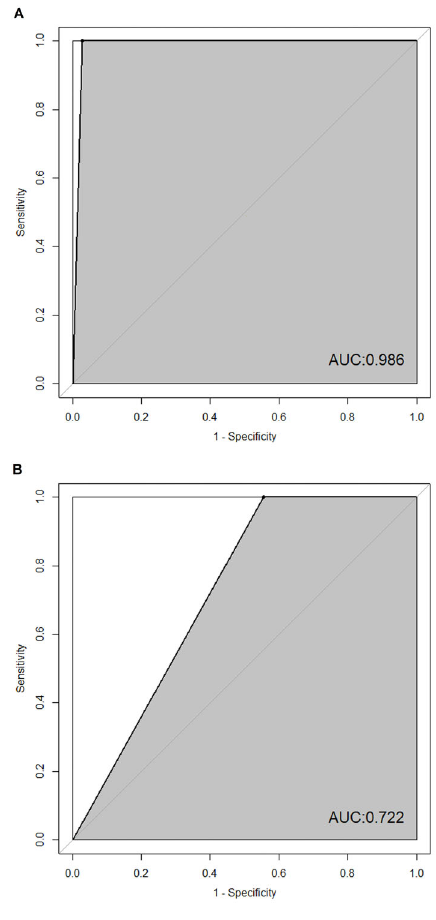
Figure 4. Receiver operating characteristic curves of the support vector machine classi fi er in prognostic prediction of pediatric septic shock. A , Performance with the training dataset. B , Performance with the testing dataset. AUC: area under the receiver operating characteristic